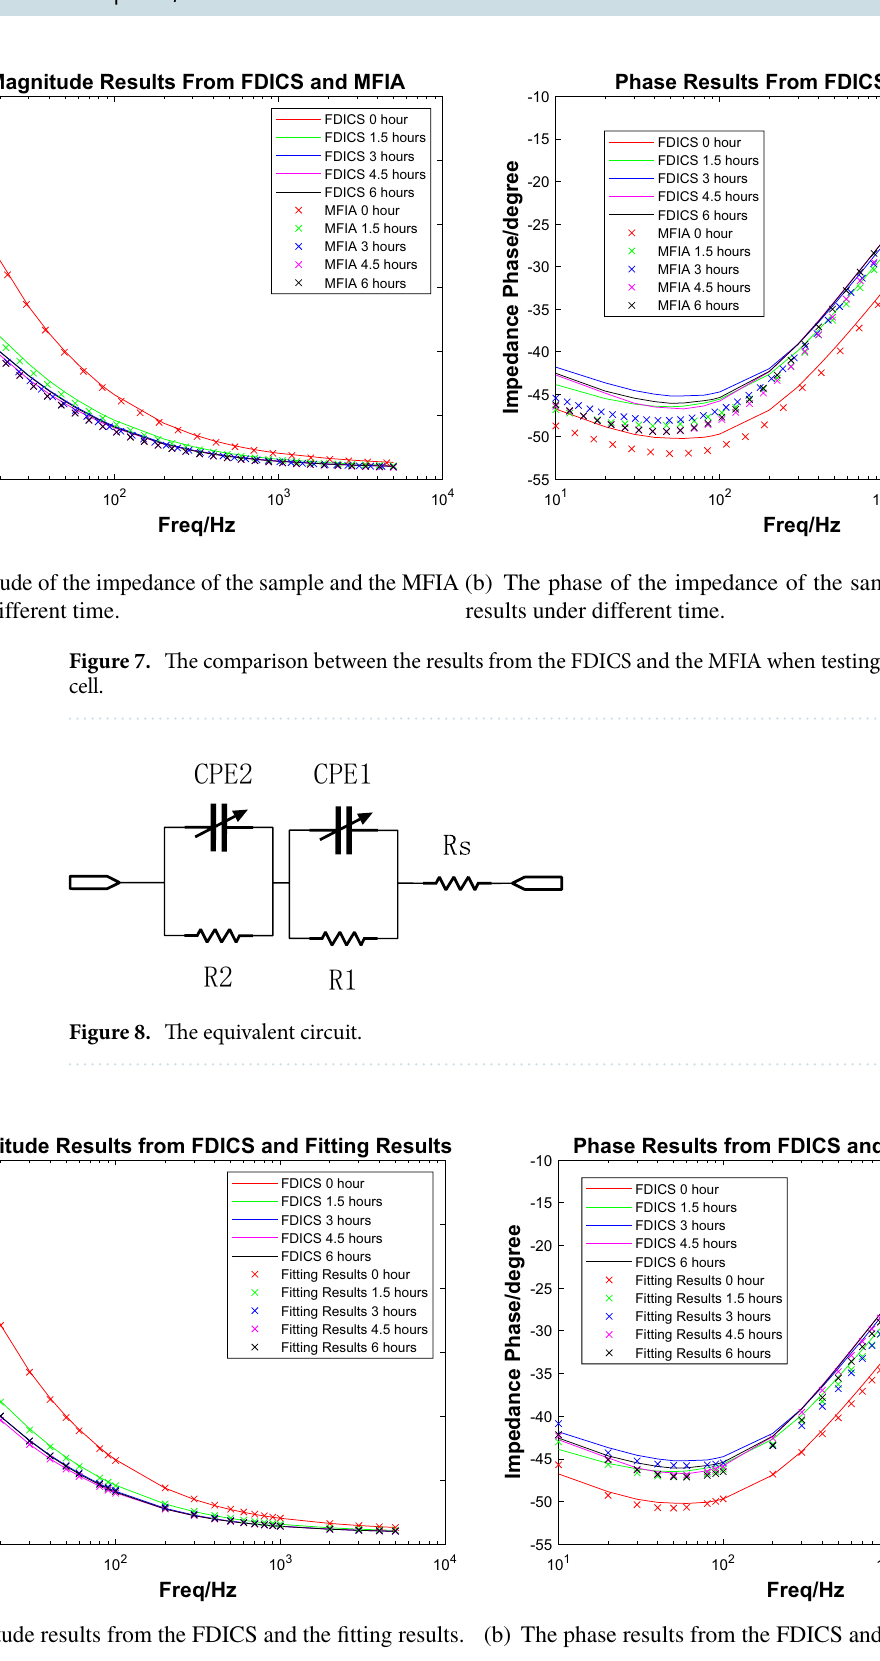
Figure 9. The impedance measurement from FDICS and the fitting